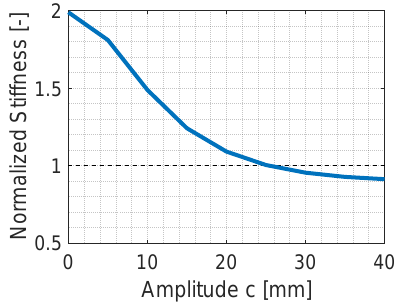
Figure 27: Evolution of the normalized stiffness D actual 66 · ( D CLPT 66 ) −1 with increasing corrugation amplitude. The lay-up is CFRP [0 4 ] , with a total thickness of t = 1 mm and a unit cell width of P = 100 mm . The results for the finite-width plates were produced using the code presented in [62] with deactivated periodicity boundary